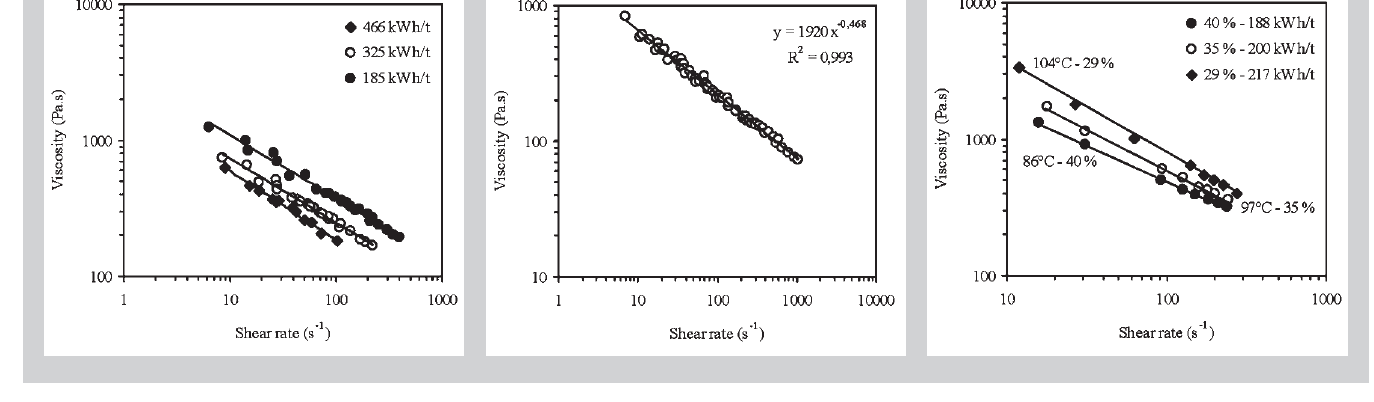
Figure 6 (left): Mastercurves of viscosity at 90°C (40% water), for three different SME. Figure 7 (middle): Mastercurve of the viscosity of the wheat starch (40% water) at 90°C and 325 kWh/t. Figure 8 (right): Viscosity curves at constant SME and barrel temperature (70°C), for three different water contents. The values indicated on the curves are the product temperatures measured at die